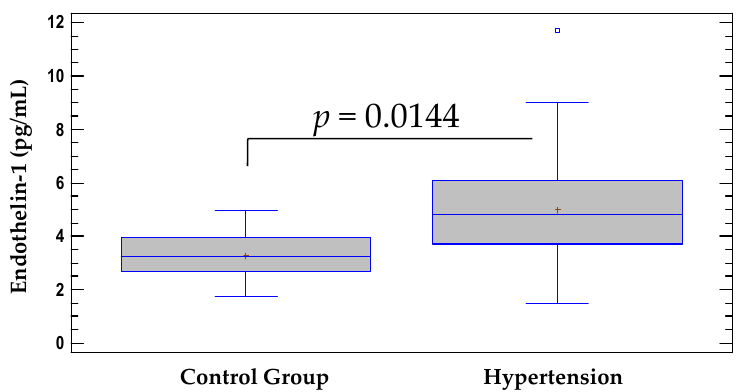
Figure 1. Serum levels of ET-1 in hypertensive group vs. control group. Data are represented as mean ± SD.